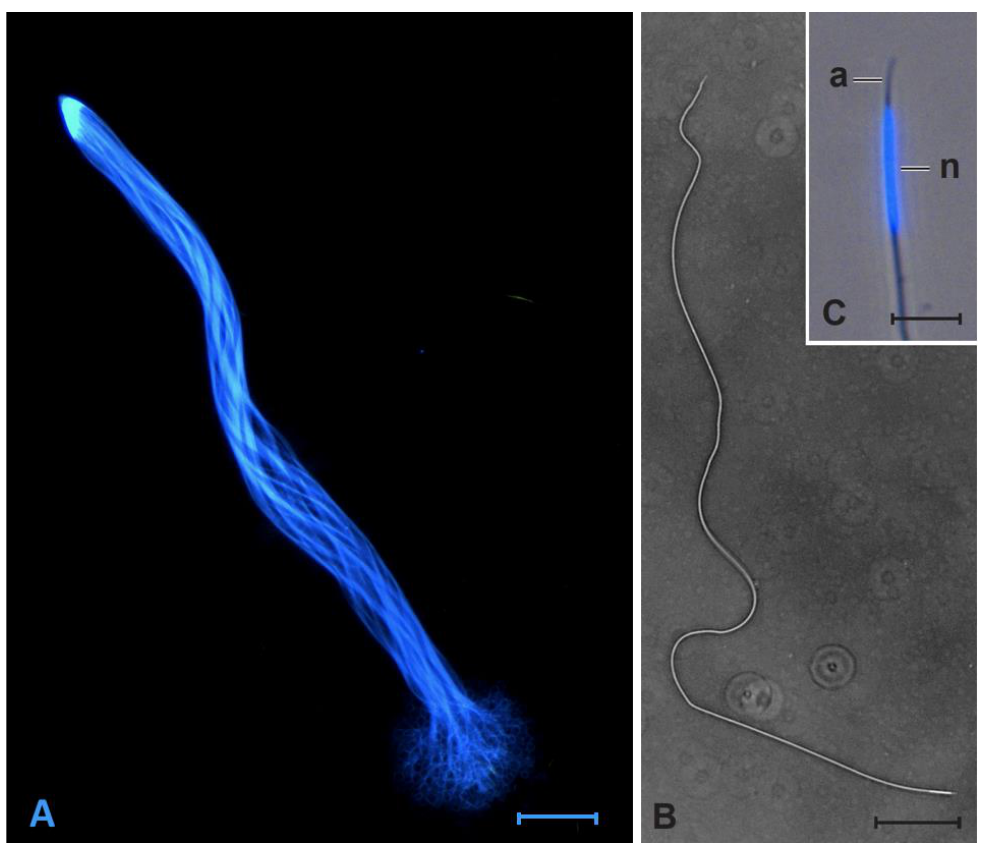
Figure 2. ( A ) A sperm bundle taken from the seminal vesicles of a sexually mature male (scale bar, 100 µ m); ( B ) an individual sperm cell (scale bar, 100 µ m); ( C ) the head region showing the acrosome (a) and nucleus (n) (scale bar, 10 µ m). B and C reprinted by permission from Springer Nature: Springer, Naturwissenschaften, Ultrustructure of spermatozoa of Onthophagus taurus (Coleoptera, Scarabaeidae) exhibits heritable variation, Michael Werner and Leigh W. Simmons, ©Springer-Verlag 2011 [57].